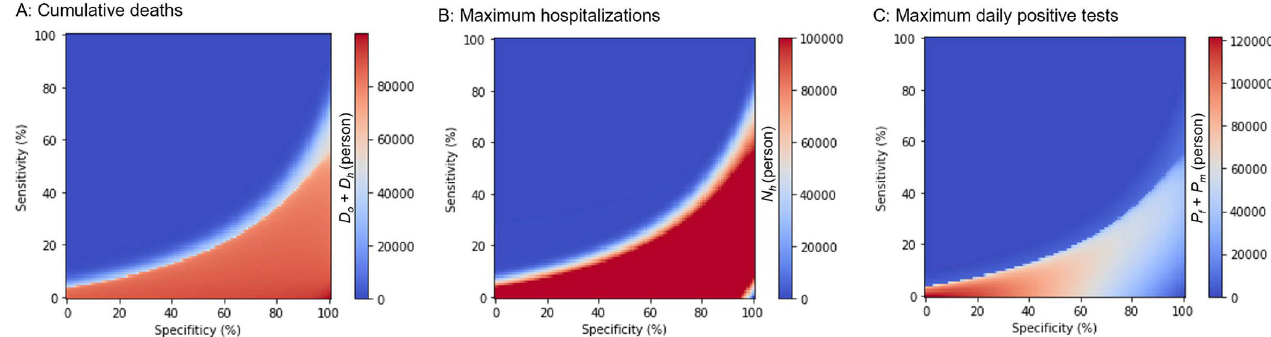
Fig 5. Infectious spread based on the testing properties. Numbers of (A) Cumulative deaths, (B) Maximum hospitalizations, and (C) Maximum daily positive tests based on the sensitivity and specificity of the testing.